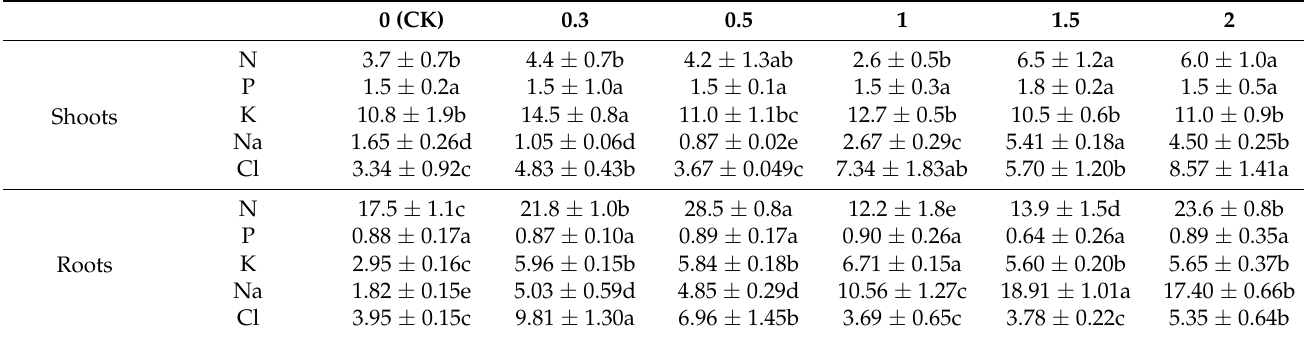
Table 1. Contents of N, P, K, Na (g/kg) and Cl (mg/kg) in vetiver plants collected 55 d after irrigation with saline